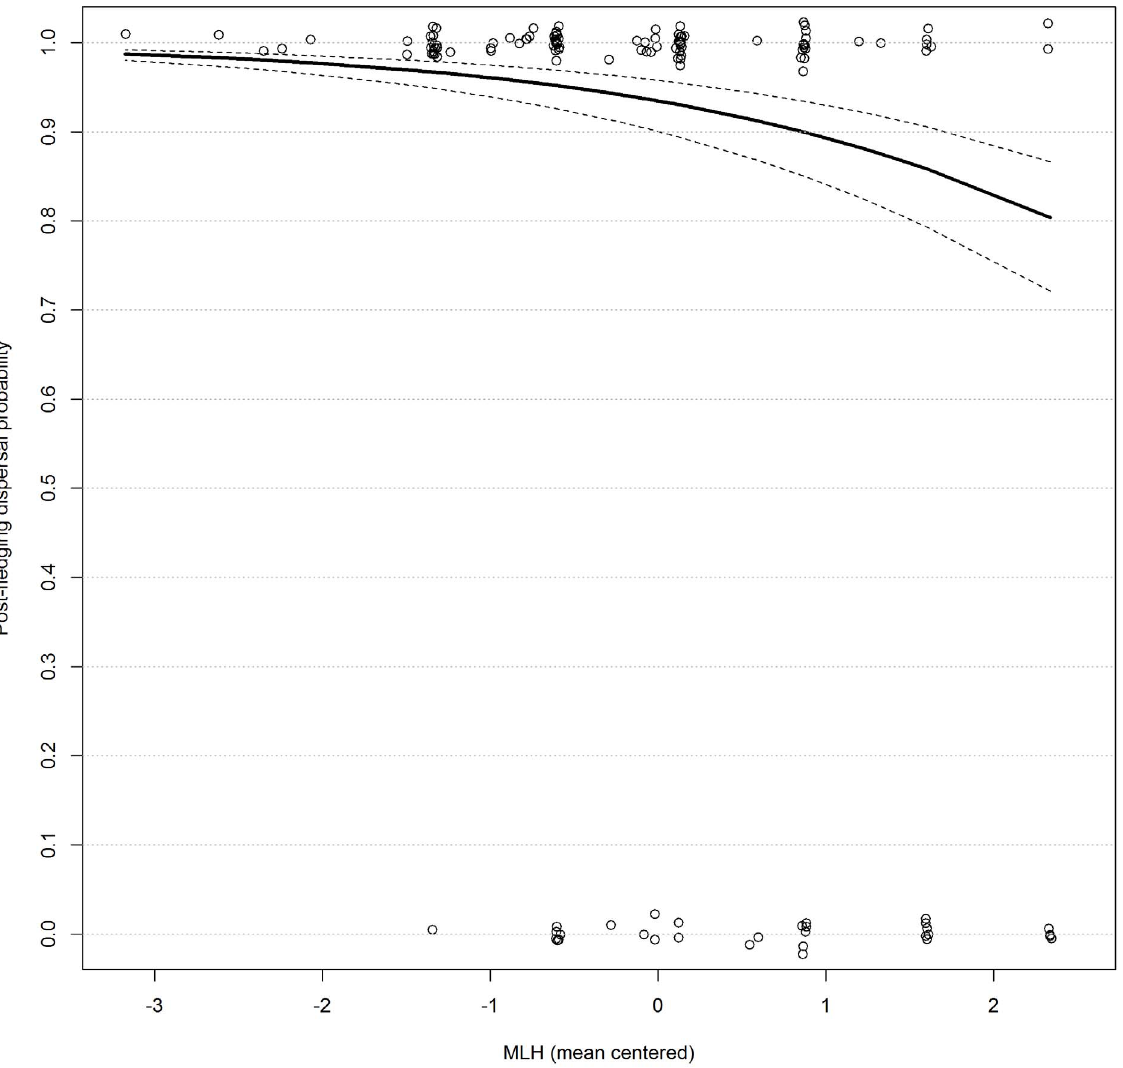
Figure 2. Probability of post-fledging dispersal according to microsatellite multilocus heterozygosity (MLH) for greater flamingos born in Camargue, southern France. 95% confidence intervals correspond to the broken lines. Model averaged estimates were extracted from models 26 and 27 (see Table 2). Circles represent the observations of whether birds that have been resighted in their first wintering site (although all estimates from models 26 and 27 are based on all 1023 individuals) dispersed (1) or not (0) for a given MLH value for a given MLH value. Overlapping points have been jittered to give a better indication of sample size for each MLH value. doi:10.1371/journal.pone.0081118.g002 Figure S3 in Appendix S2) confirming previous results for the same cohorts [6,30]. We found that a model with the effect of MLH on propensity to disperse to the long-distance sites of Africa was equivalent to the null model. MLH may therefore have no effect on post-fledgling dispersal distance. Alternatively, we may have lacked the statistical power to detect the weaker positive effect of MLH on post-fledging dispersal distance (approximately half as strong as the effect on post-fledgling dispersal propensity) among fledglings that have chosen to disperse. The latter suggests that homozygotes post-fledging dispersers may tend to select the intermediate-distance sites of Italy or the Iberian Peninsula and heterozygotes the long-distance sites of Africa. One possibility, then, is that the negative effect of inbreeding depression also negatively affects dispersal ability during transience and that homozygotes were less able to disperse to the longer-distance sites of Africa than heterozygote dispersers, which would be consistent